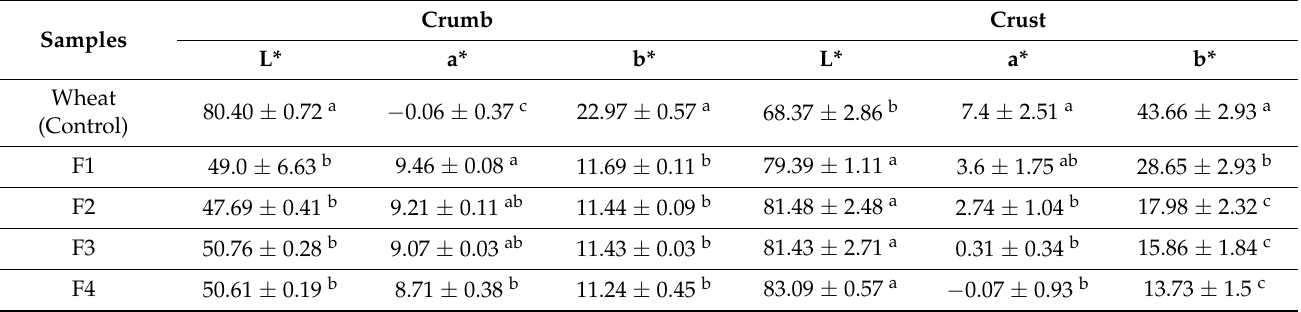
Table 4. Colour analysis of wheat bread and gluten-free rice bread.